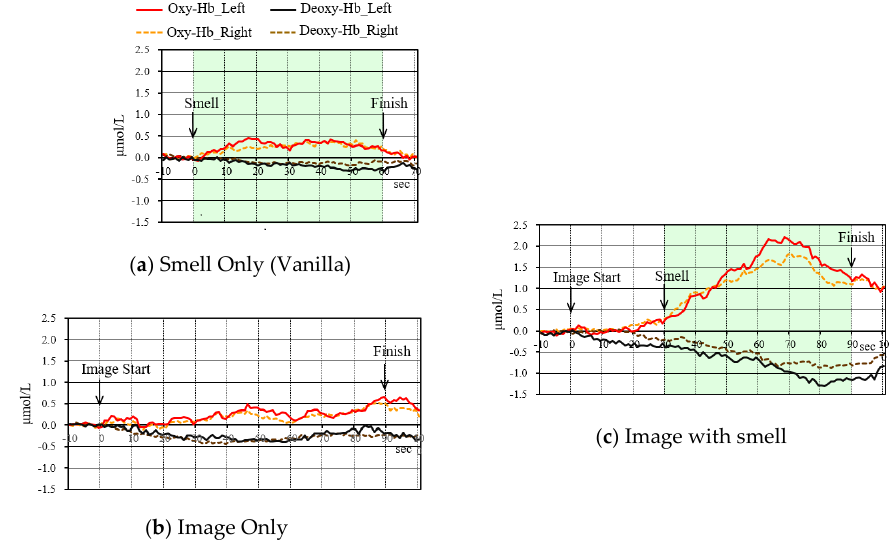
Figure 10. NIRS results of the almond/pudding cake study, clarified by integrating 12 subjects. (Solid lines/dotted lines: left/right temple regions). (Red/black: Oxy-Hb/Deoxy-Hb). (Solid lines / dotted lines: left / right temple regions). (Red / black: Oxy-Hb /